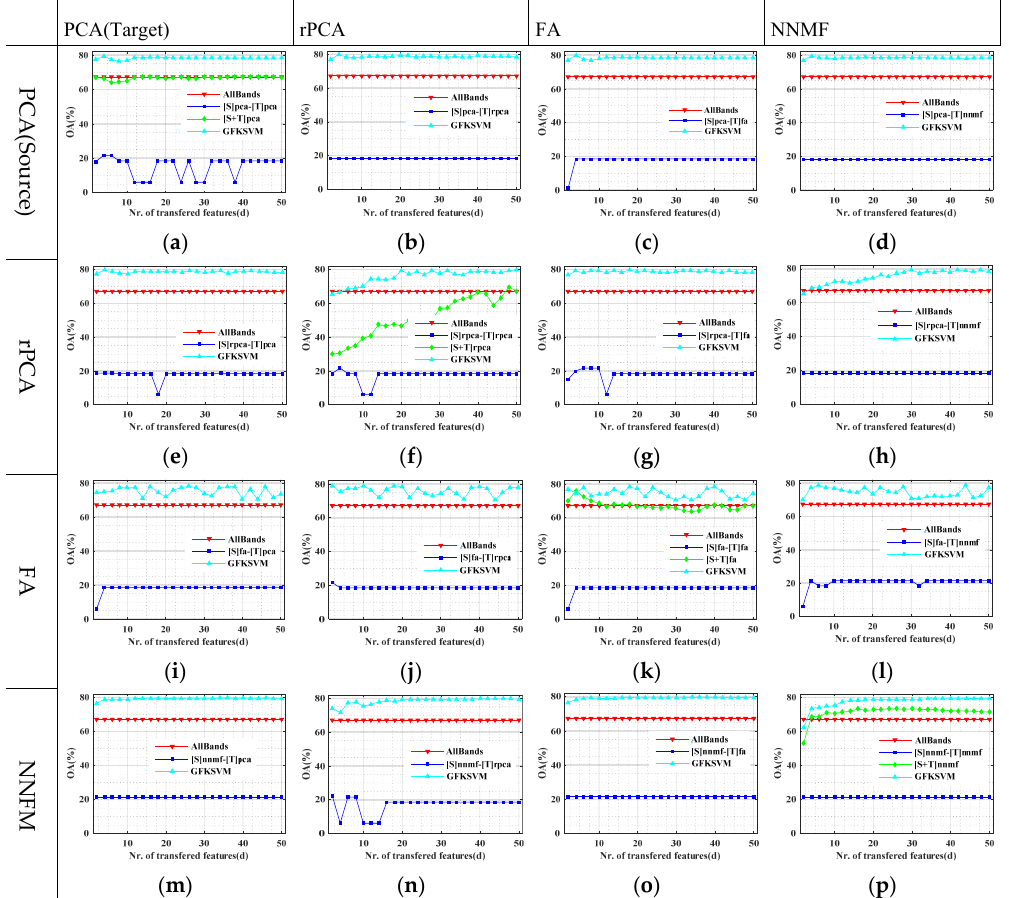
Figure 11. Classification accuracy curves for GFKSVM using different subspace feature transfer approaches on the ROSIS data set (University → Center). ( a ) PCA-PCA; ( b ) PCA-rPCA; ( c ) PCA-FA; ( d ) approaches on the ROSIS data set (University Ñ Center). ( a ) PCA-PCA; ( b ) PCA-rPCA; ( c ) PCA-NNMF; ( e ) rPCA-PCA; ( f ) rPCA-rPCA; ( g ) rPCA-FA; ( h ) rPCA-NNFM; ( i ) FA-PCA; ( j ) FA-rPCA;